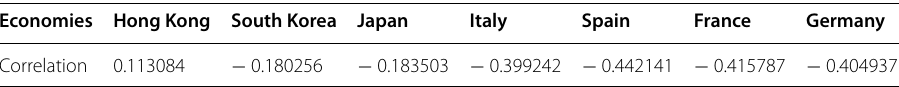
Table 5 Correlation between ln